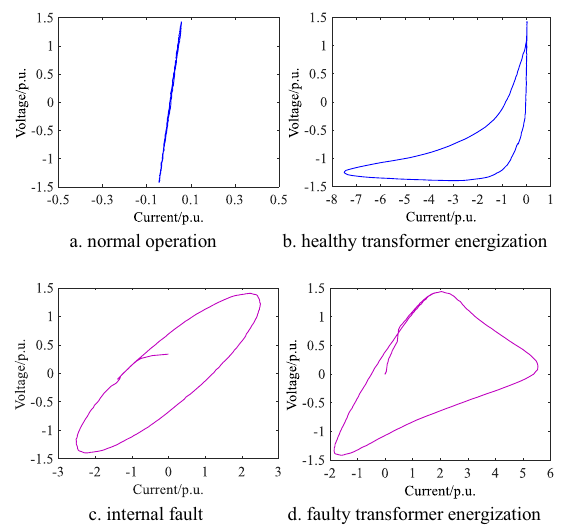
Fig. 1 VICurs under various operating states